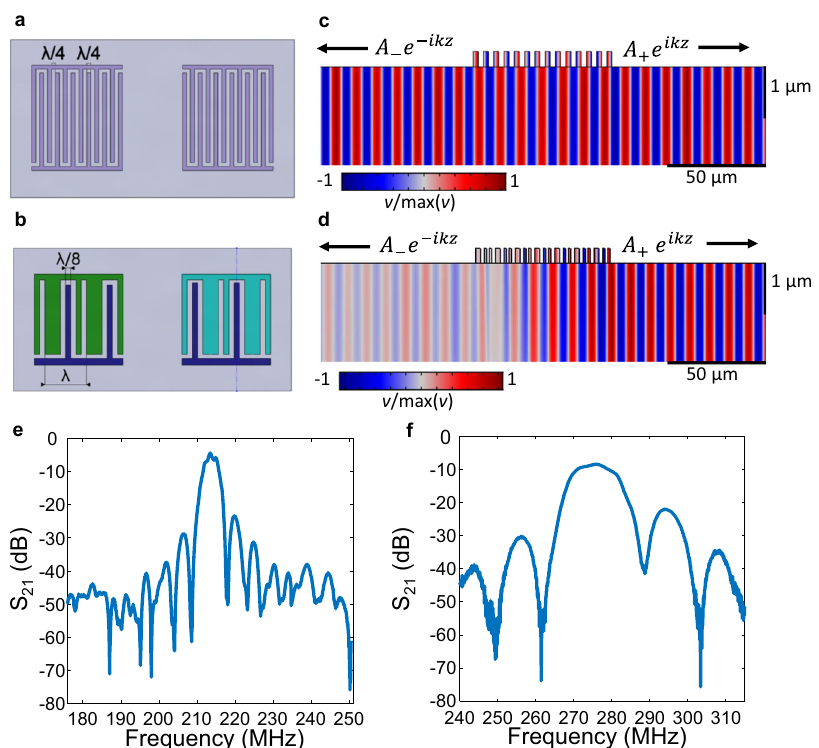
Fig. 3 Acoustic delay line. Schematics of a ( a ) traditional IDT delay line and a ( b ) SPUDT design with corresponding simulated normalized displacement fi elds shown in c and d , respectively. The LiNbO 3 substrate is shown in light gray, the aluminum for the traditional IDTs is shown in light purple, and the aluminum for the SPUDT IDTs is shown in dark purple, green, and cyan. λ denotes the acoustic wavelength, A (cid:2) e (cid:2) ikz describes the backward propagating wave, A þ e ikz describes the forward propagating wave, and v is the displacement along the y -axis. Measured S 21 as a function of frequency for SPUDT delay lines on ( e ) YZ LiNbO 3 supporting a Rayleigh SAW mode with a resonant frequency of 214 MHz and ( f ) 41° YX LiNbO 3 supporting an SH-SAW mode with a resonant frequency of 276